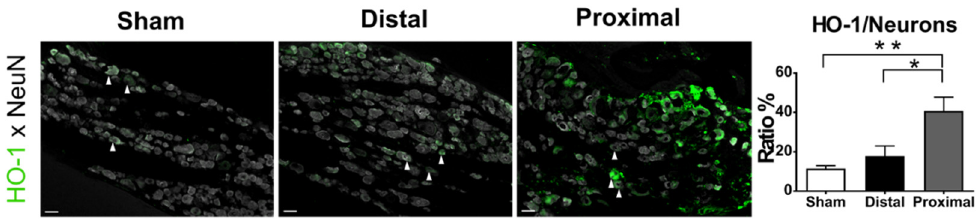
Figure 3. Tissue hypoxia of L5 DRGs at post-operative day 1. Tissue hypoxia was examined in rats labelled with hypoxiaprobe-1 (HO-1, arrowheads), and the L5 DRG sections were stained with FITC-conjugated antibodies recognizing pimonidazole-protein adducts. The ratios of HO-1 positive neurons in L5 DRGs were compared between distal nerve constriction (Distal), proximal nerve constriction (Proximal), and sham operation (Sham) groups. Data are mean ± SEM, N = 6 rats in each group. * p < 0.05, ** p < 0.01 between groups, scale bar = 50 μ m.